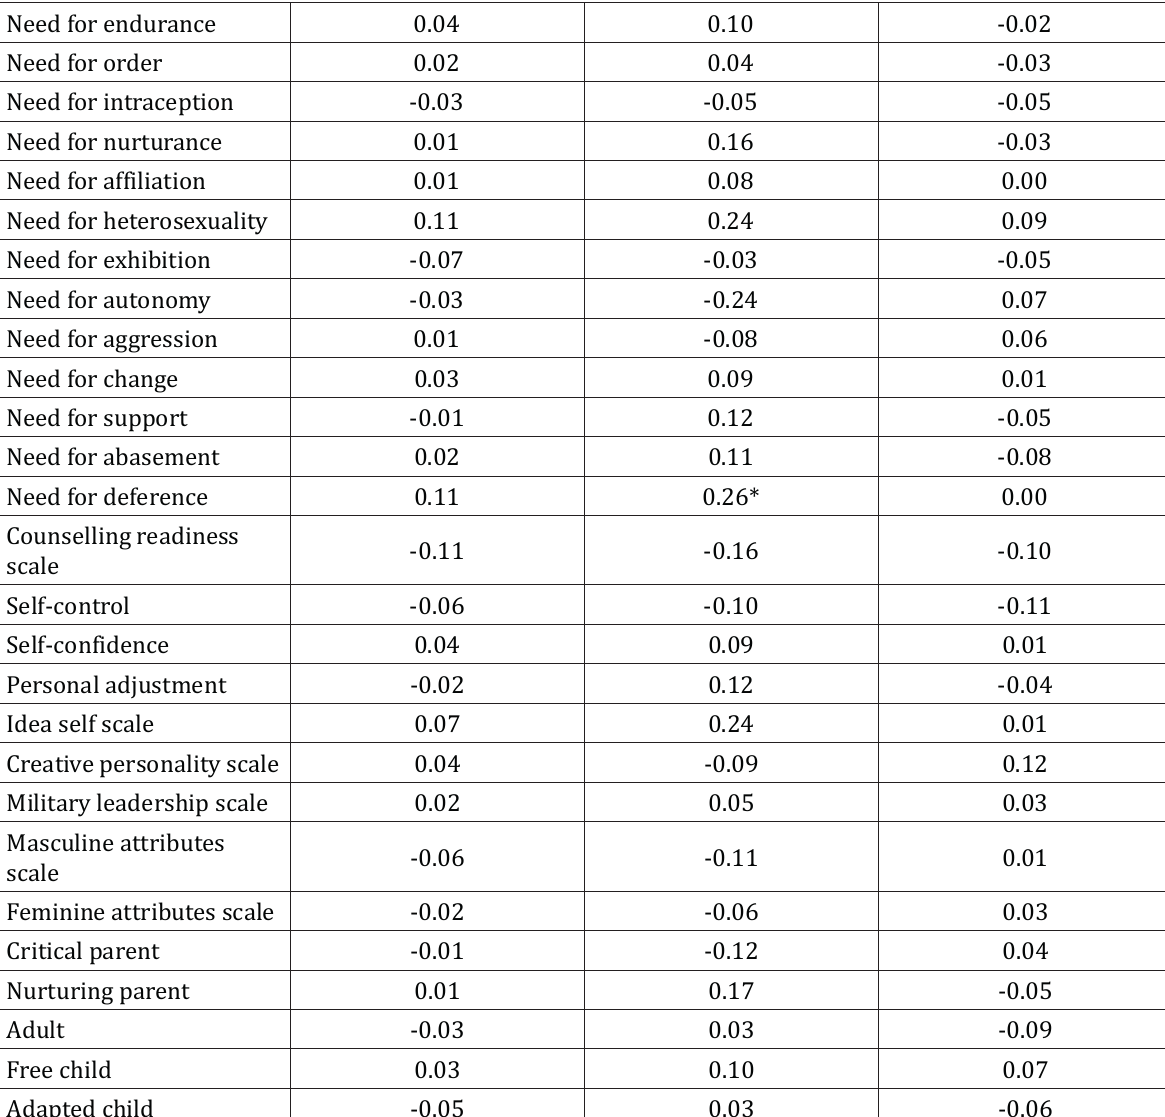
To test Hypothesis Pearson's correlation coefficients (r) were calculated between the respondents' daily SNS usage times and their SVF scores (Table 3).